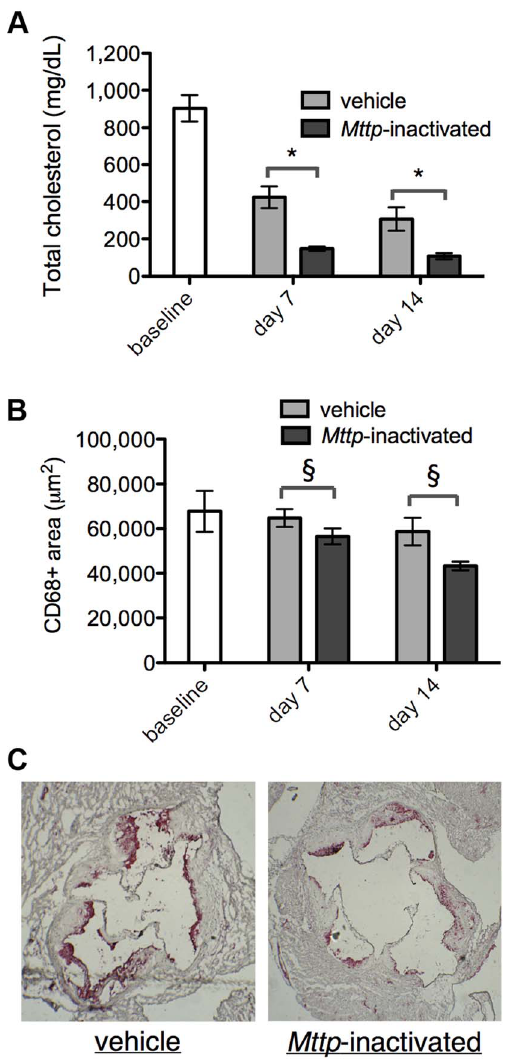
Figure 1. Reversal of hyperlipidemia in Reversa mice reduces plaque macrophage content. (A) Plasma cholesterol levels were reduced upon switching to chow diet and upon inactivation of Mttp . Bars are mean 6 SE. Cholesterol differences between vehicle and Mttp - inactivated are: at day seven, 65% reduction; at day 14, 65% reduction. The cholesterol reduction in Mttp -inactivated vs. vehicle, at days seven and 14, is significant with P , 10 2 4 [(*) two-way analysis of variance (ANOVA)]. For all bars, N =5 except for baseline, where N =7. (B) Mttp inactivation contributes to a reduction in macrophage content of the plaque . Bars are mean 6 SE. CD68 + area differences between vehicle and Mttp -inactivated are: at day seven, 13%; at day 14, 26%. The CD68 + area reduction in Mttp -inactivated vs. vehicle groups, at both days seven and 14, is significant with P , 0.05 ( 1 , two-way ANOVA). For all bars, N =7 except day seven, where N =9. The difference in CD68 areas between day 14 (or day seven) saline-treated groups and baseline were not statistically significant. (C) Mttp inactivation reduces CD68 cellular content within aortic root plaque . Micrographs are representative aortic root sections from day 14 animals (from vehicle and Mttp -inactivated groups, as indicated) that have been counterstained with hematoxylin (blue) and immunostained for CD68